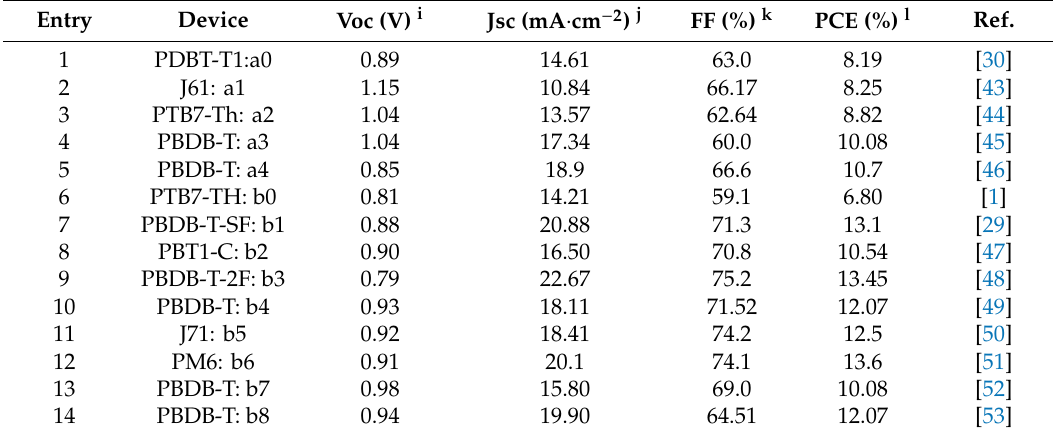
Table 2. Photovoltaic properties of best devices incorporating NFA acceptors shown in Figure